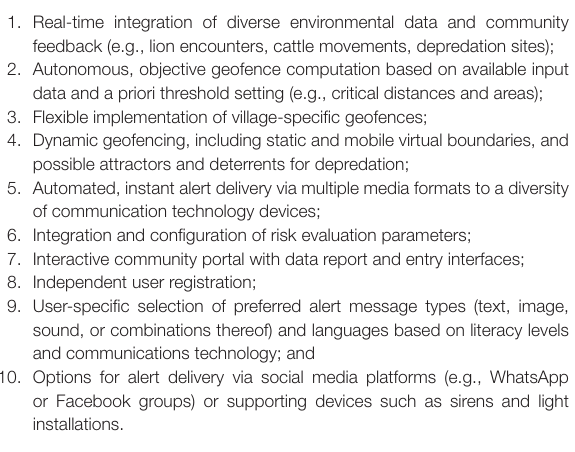
Box 1 | Key features and capabilities of the autonomous lion alert